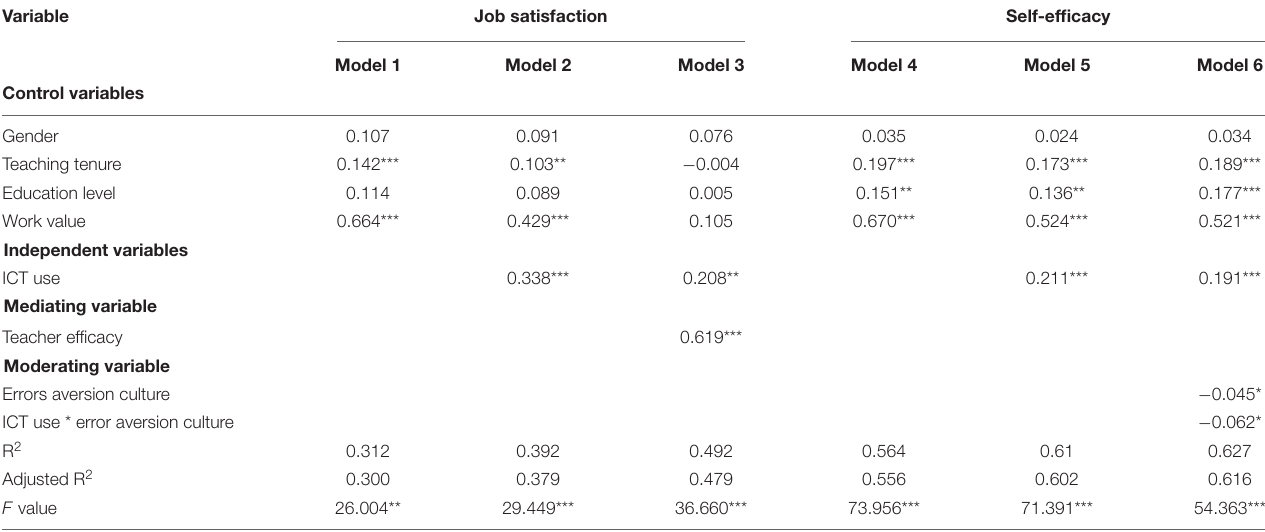
TABLE 4 | Results of regression analysis.